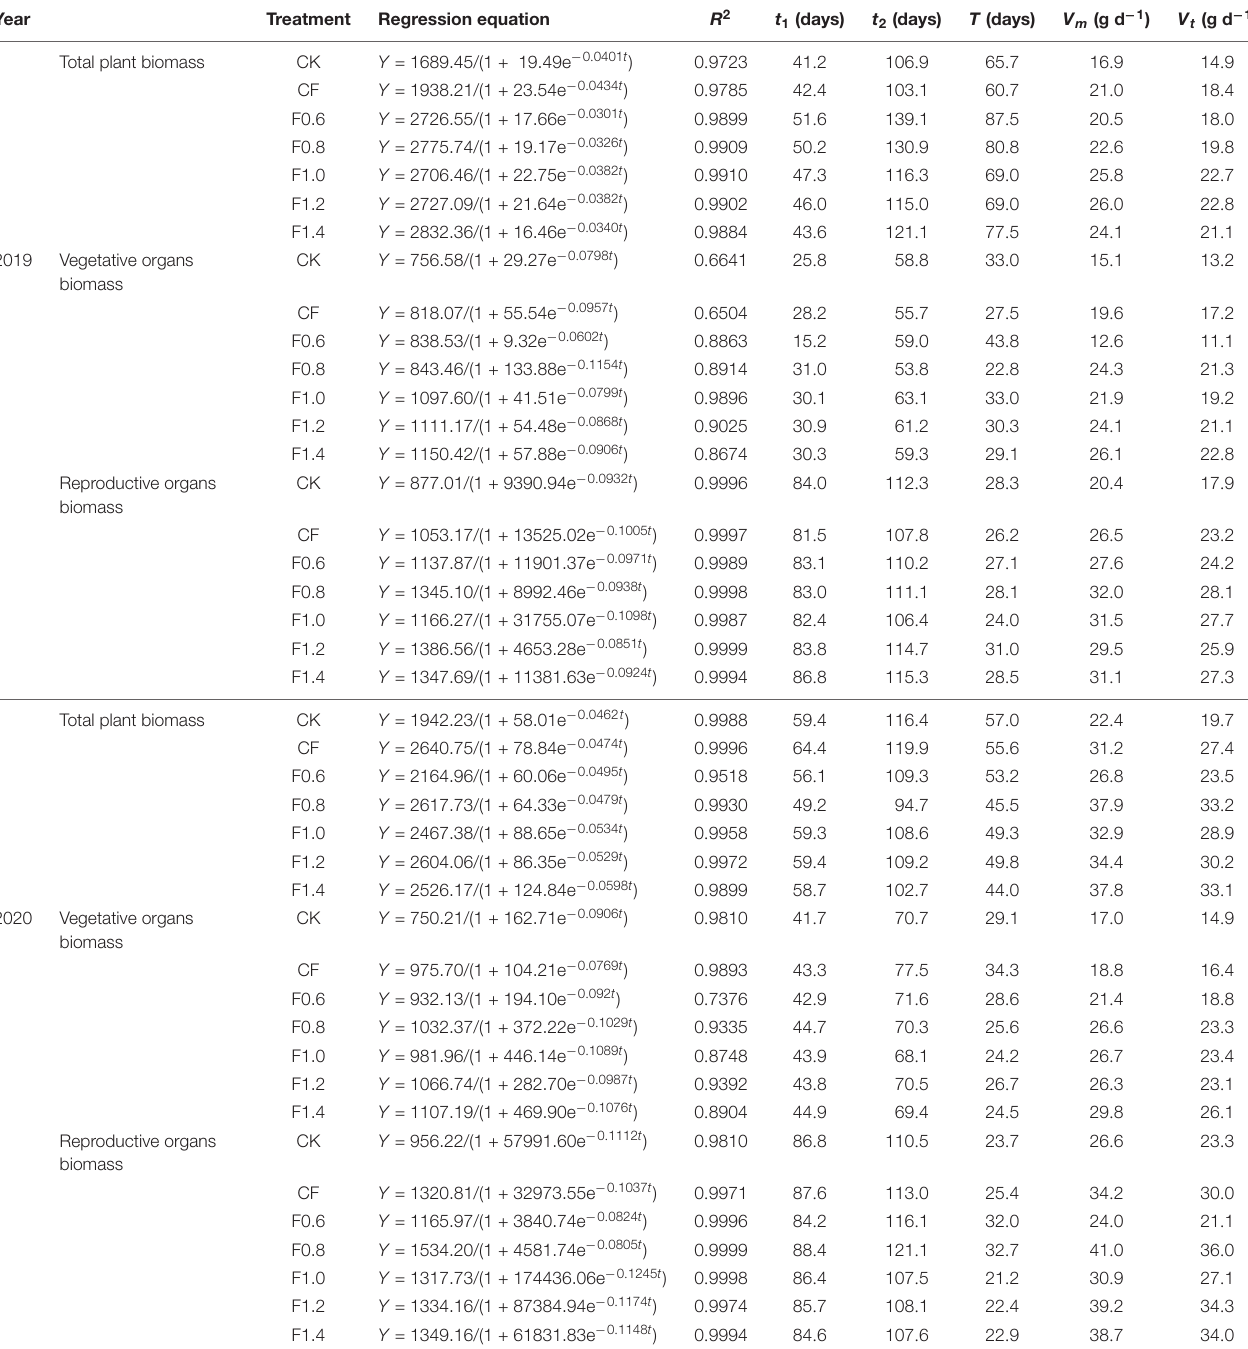
TABLE 3 | Biomass accumulation equations of cotton in different organs and eigenvalues of cotton biomass accumulations under different fertilization treatments. Year Treatment Regression equation R